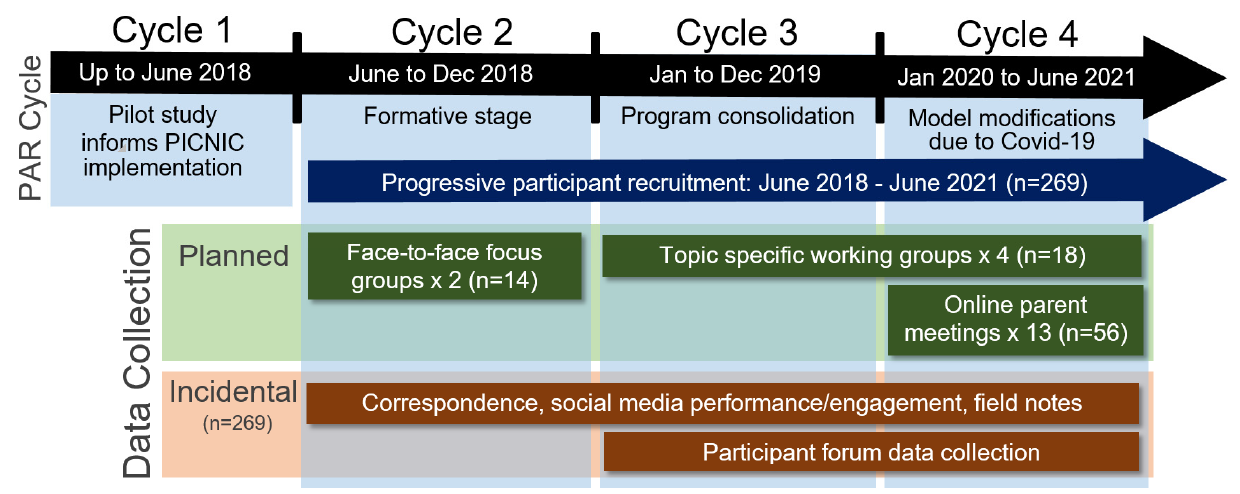
Figure 1. PICNIC PAR cycles, duration, and data collection.